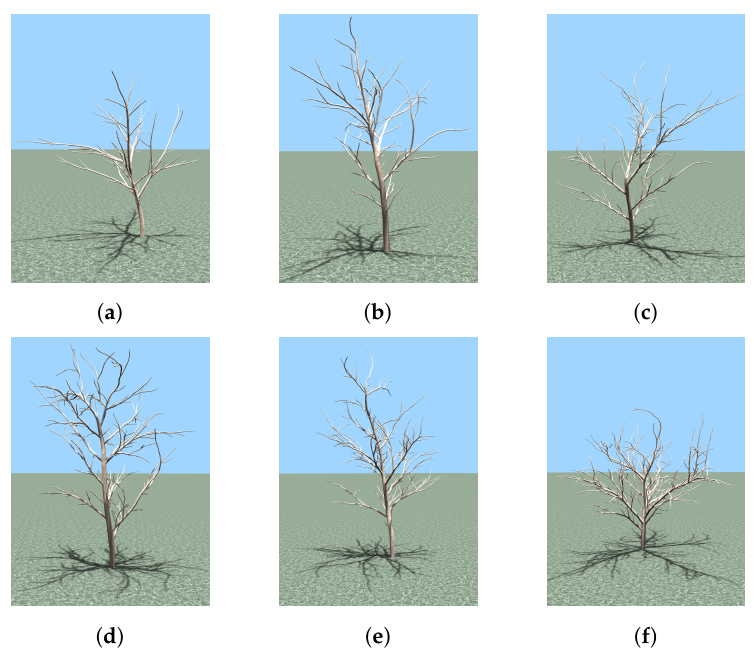
Figure 6. Tree models used in the experiments. Table 1. Characteristics of experimental tree models.